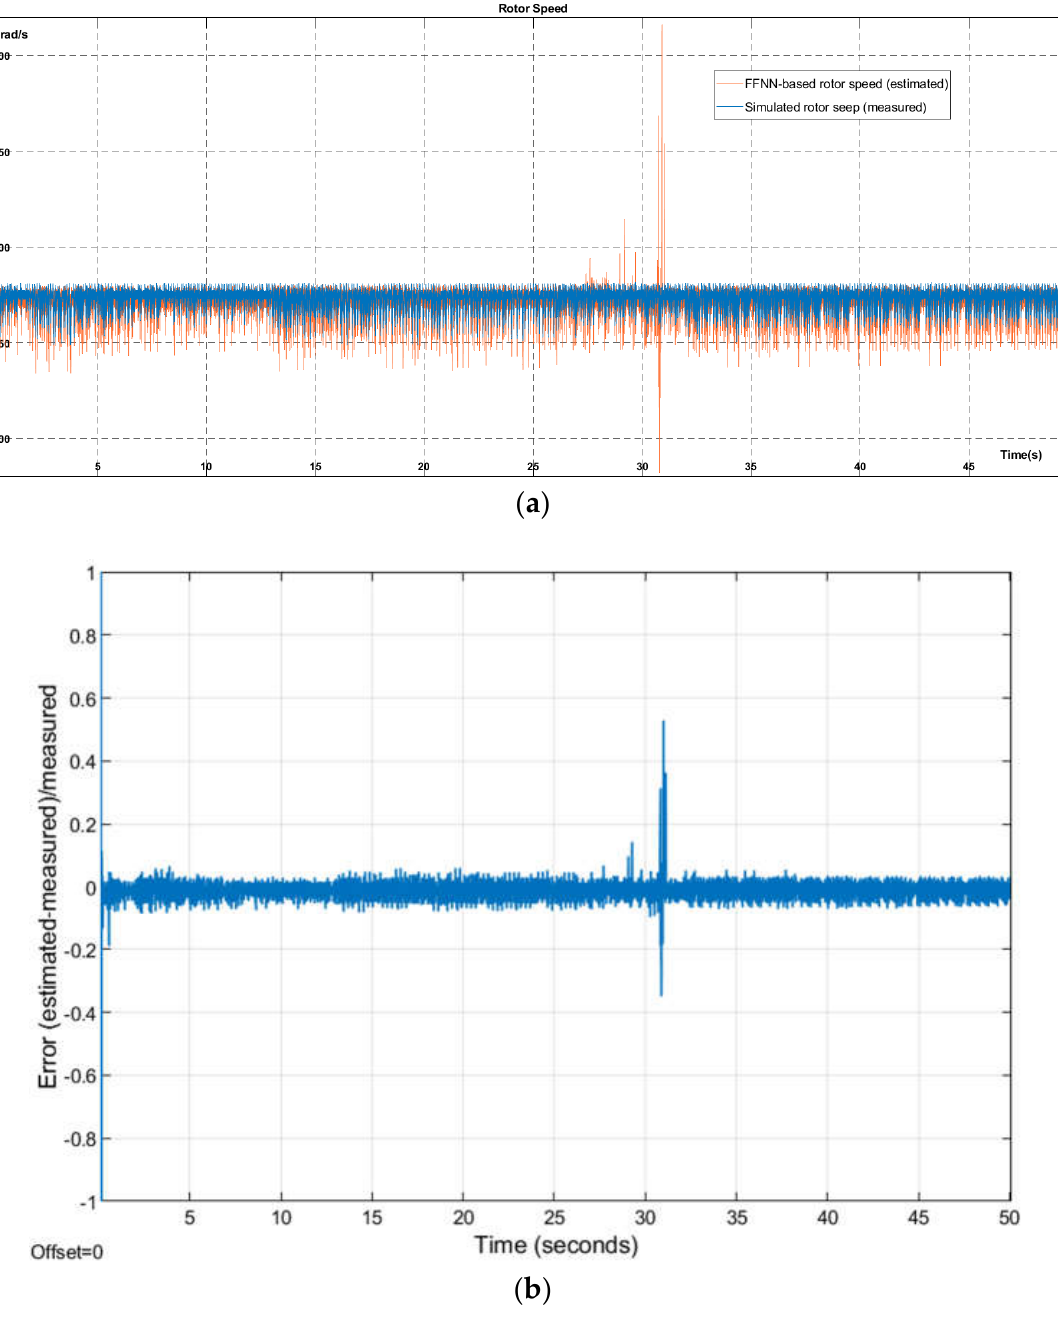
Figure 18. ( a ) Rotor speed ω r measured (orange) using the IM drive Simulink model, estimated (blue) by the generated block from ‘ff_net’; ( b ) Rotor speed error between measured and estimated ω r (scaled to 1.0).